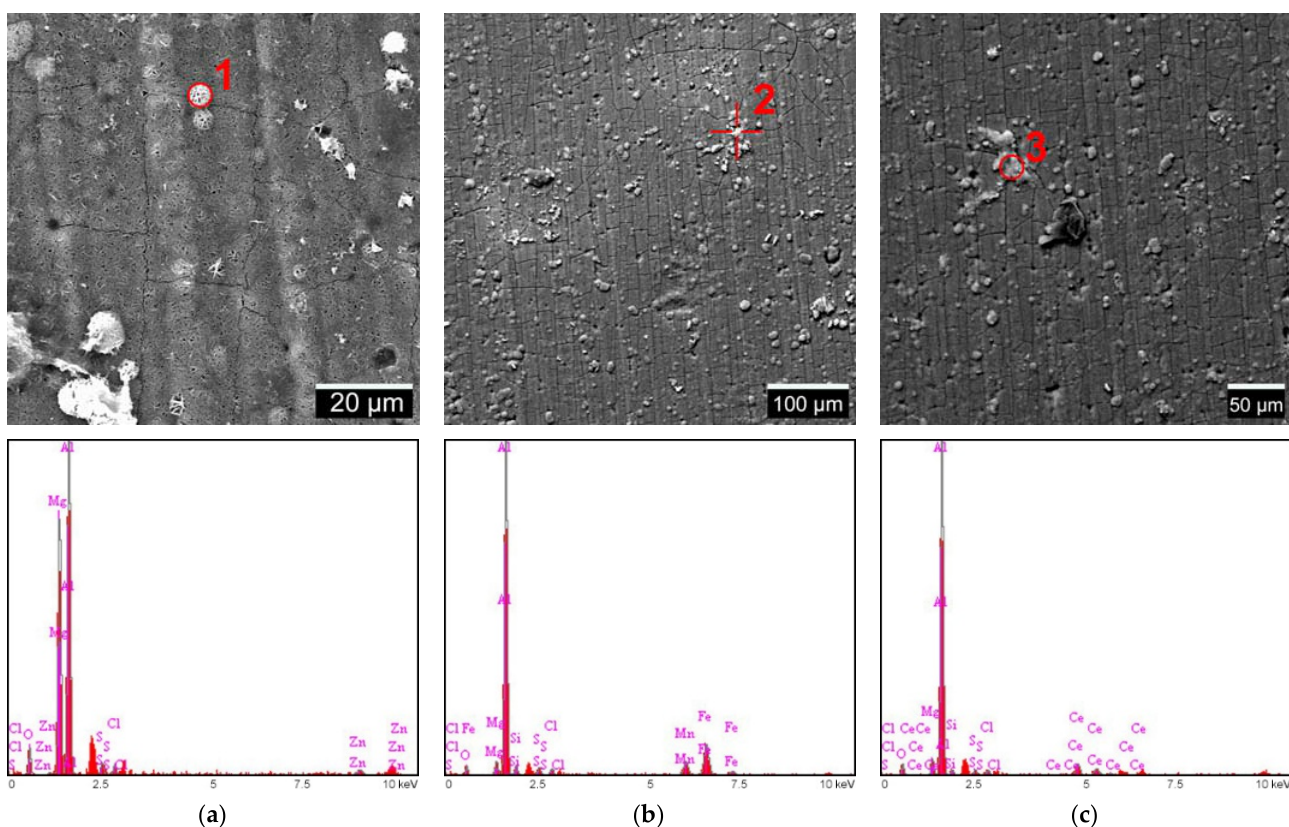
Figure 9. Three types of agglomerates found on C10-4.5 surface after 400 h of immersion in 0.1 M NaCl ( a – c ). At the bottom, the respective EDS analysis.